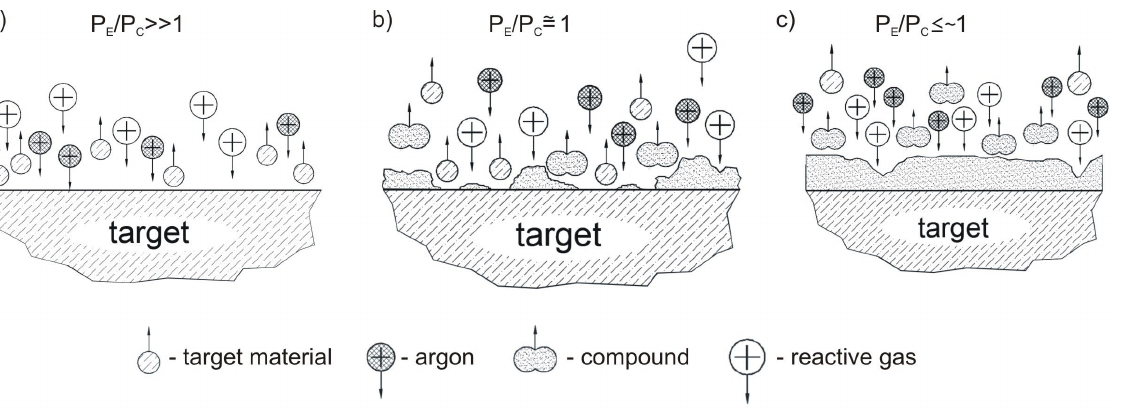
Figure 2. Schematic view of the formation of the reactive compound on the surface of the sputtered material as a function of the electrical parameters of the DPS power supply: ( a ) metallic mode (Ar atmosphere)—target surface not covered by the compound; ( b ) shallow dielectric mode—target surface partially covered by a compound; ( c ) deep dielectric mode (O 2 atmosphere)—target surface completely coated with the compound.